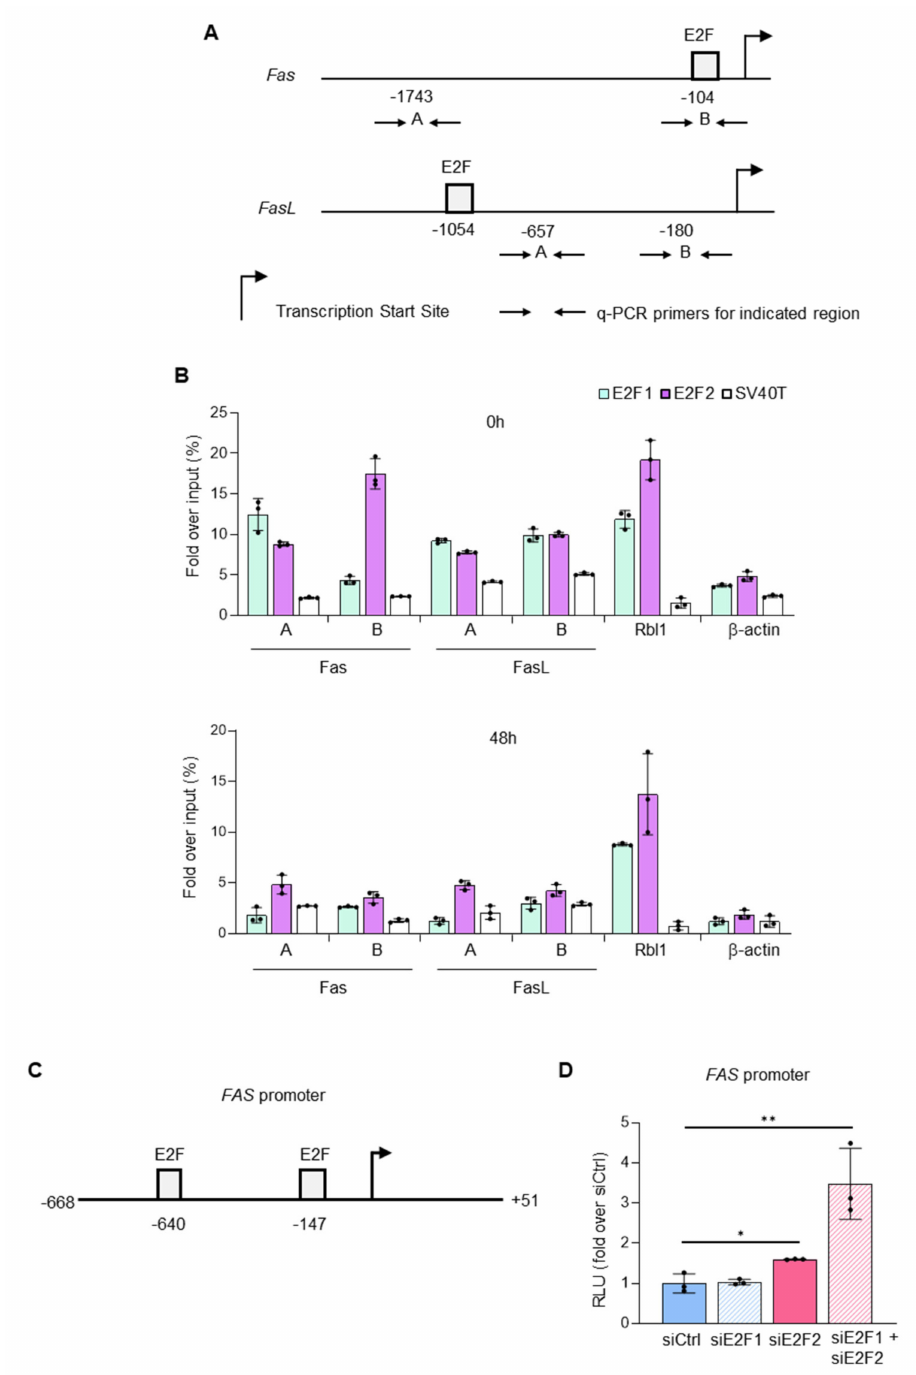
Figure 5. E2F2 regulates expression of Fas and FasL at the transcriptional level: ( A ) Schematic representation of murine Fas and FasL promoter regions, indicating the localization of consensus E2F motifs detected with Consite at a 0.85 threshold level. The nucleotide positions are numbered relative to the transcriptional start site. Arrows depict the location of primers used for qPCR analysis of immunoprecipitated chromatin sequences, and letters indicate the DNA region analyzed in the qPCRs. ( B ) ChIP-qPCR analyses of Fas and FasL promoter regions in freshly purified resting (upper panel) and TCR-activated (lower panel) WT lymphocytes. Data from a representative experiment out of three independent experiments (results obtained in Exp. 2 and Exp. 3 are in